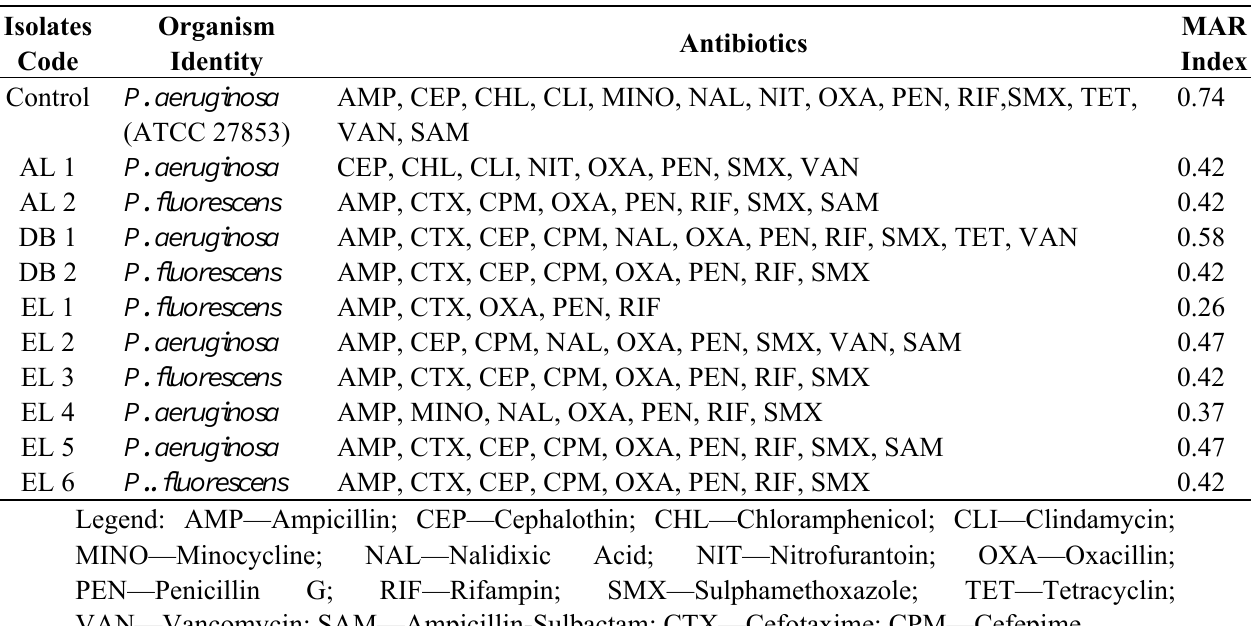
Table 3. Multiple antibiotics resistance (MAR) of the Pseudomonas